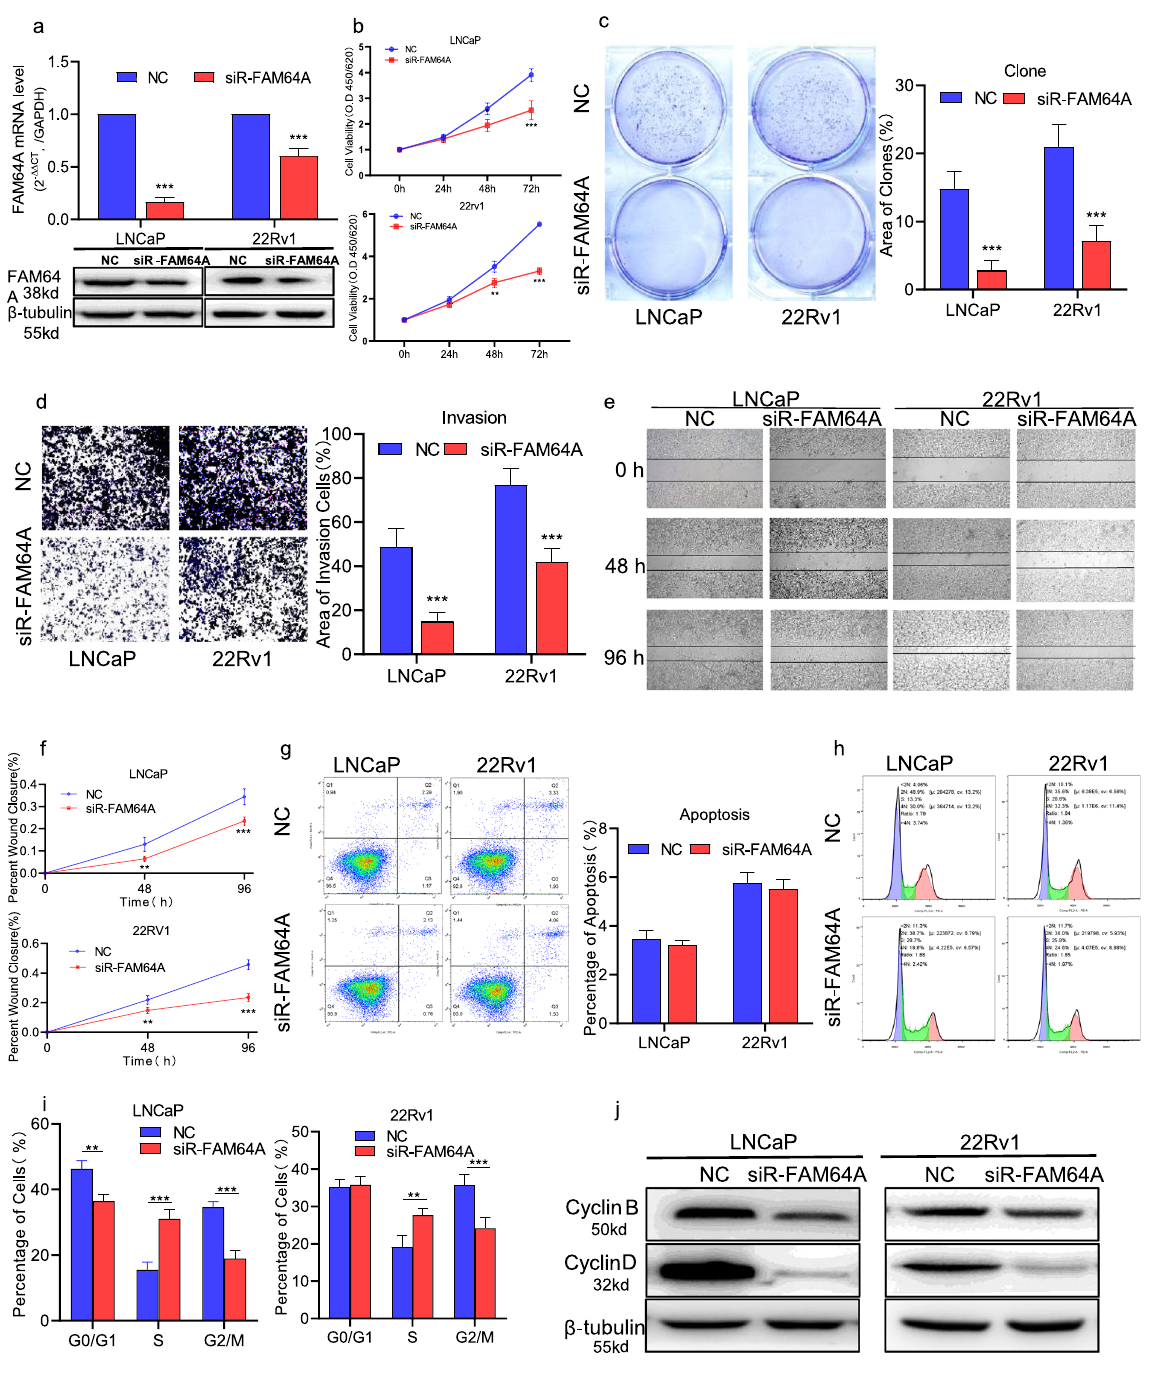
Fig. 2 FAM64A promotes the proliferation, migration/invasion, and cell cycle of PCa cells. a The mRNA and protein level of FAM64A in PCa cell lines LNCaP and 22Rv1 with transfection of siRNA-FAM64A was noteworthy lower than that in the control group. b , c CCK-8 assay and colony formation assay showed that knockdown of FAM64A decreased the proliferation of PCa cells. d Transwell invasion assay indicated that knockdown of FAM64A reduced the invasive activity of PCa cells. e , f Wound healing assay indicated that knockdown of FAM64A reduced the migratory ability of PCa cells at 0, 48, 96 h. g Flow cytometry with Annexin V-FITC and PI staining indicated that knockdown of FAM64A could not impact cell apoptosis. h , i Flow cytometry analysis indicated that knockdown of FAM64A postponed the progression of the cell cycle. j Western blot analysis showed that knockdown of FAM64A downgulated the expression of cycle-related protein cyclin B1 and cyclin D. ** P < 0.01, *** P < 0.001.